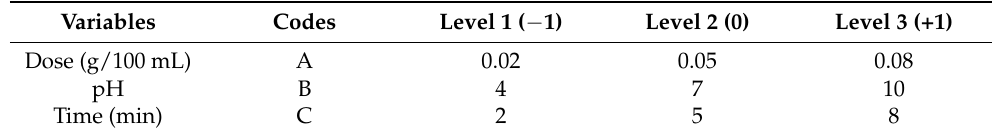
Table 1. Different variables and their levels for MB